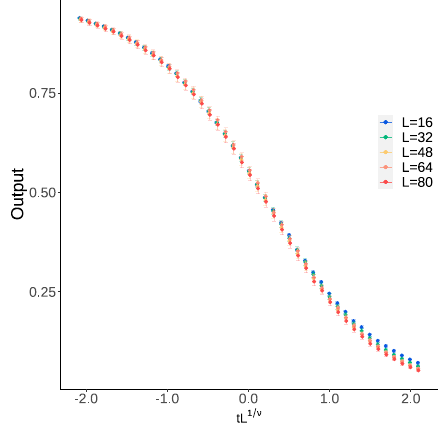
Figure 21: q = 2: The finite-size scaled plot of the average output of an ensemble of 10 independently trained ANNs – training with MC data of the antiferromagnetic square-lattice Ising model, and testing with MC data of the antiferromagnetic 2-state Potts model on a square lattice. The error bars shown are 99.7% confidence intervals of the ensemble